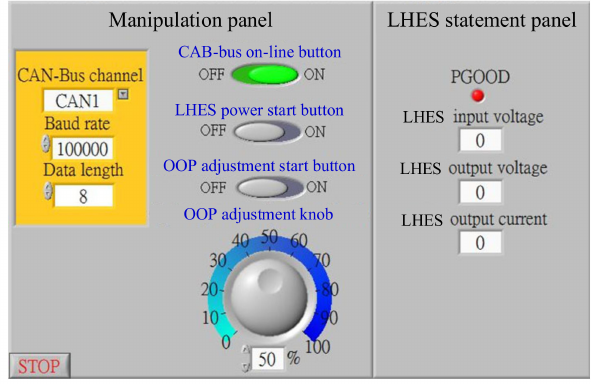
Figure 4. Human–machine interface of LHES.